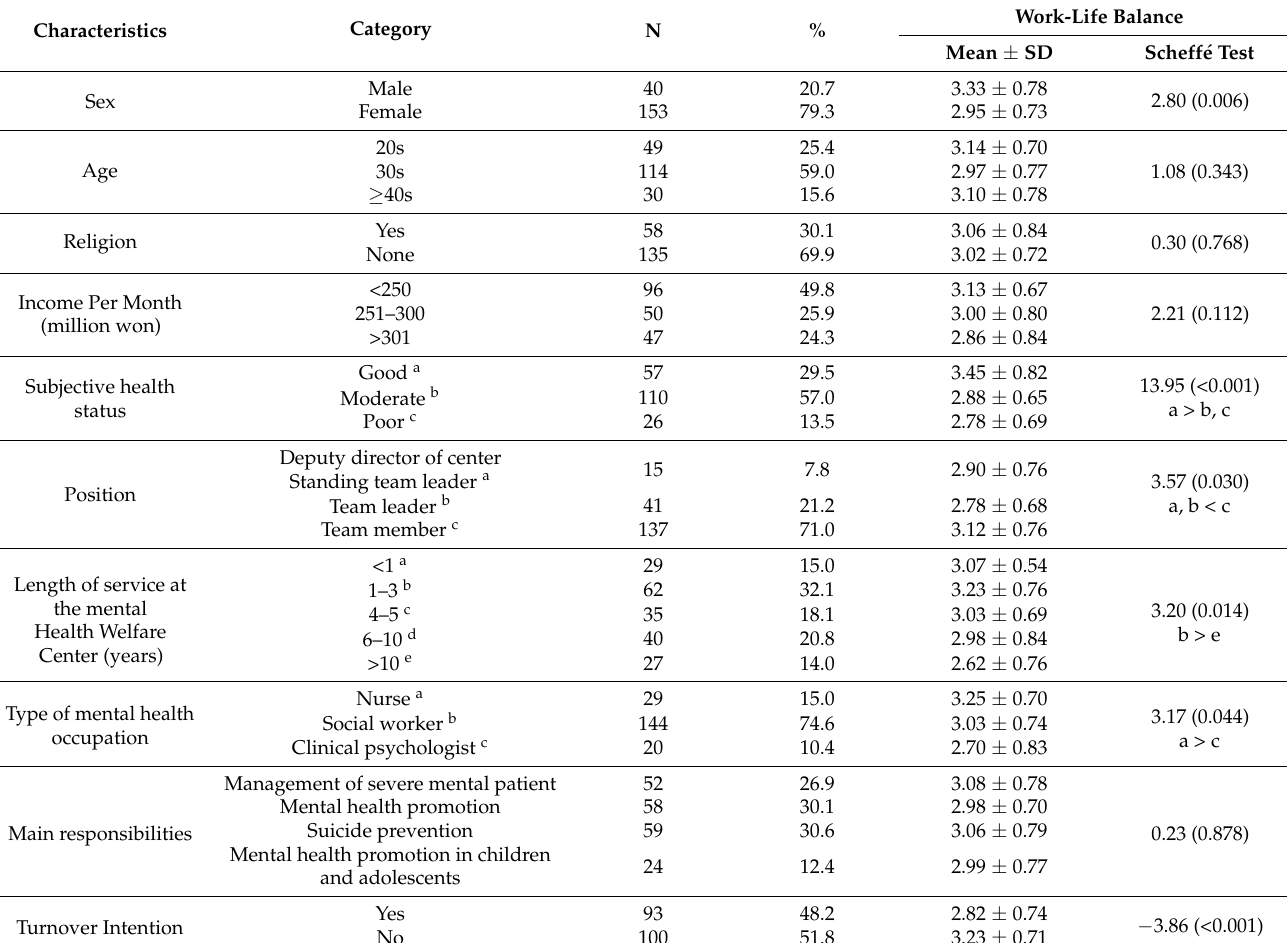
Table 1. Work-Life Balance Based on Participant Characteristics ( N =